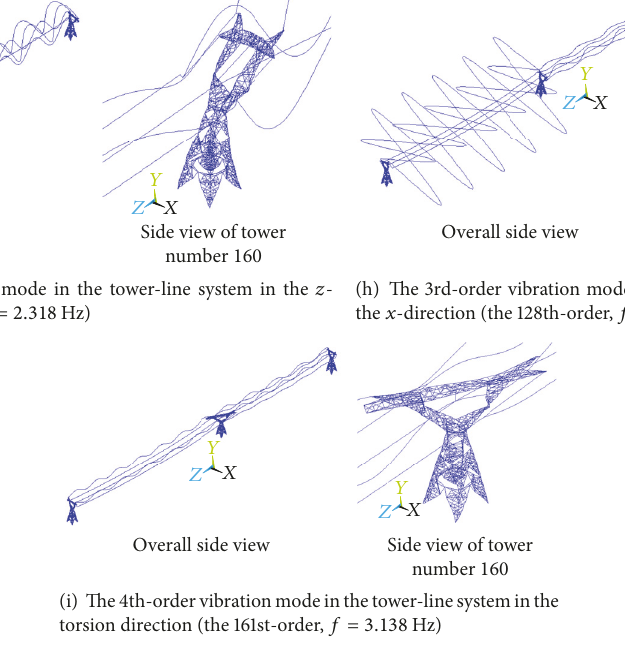
Figure 4: Vibration modes of the transmission tower-line